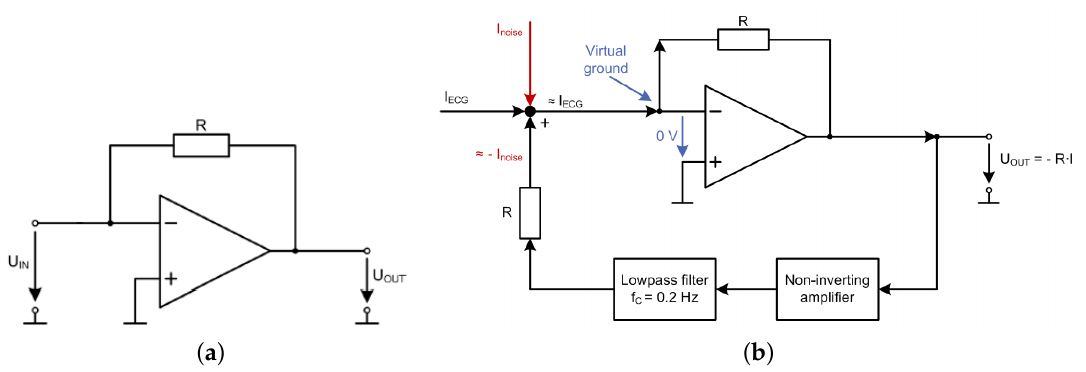
Figure 3. ( a ) Transimpedance amplifier converting the current input signal into a voltage output signal. ( b ) Structural model of the feedback loop to reduce DC/low-frequency interring